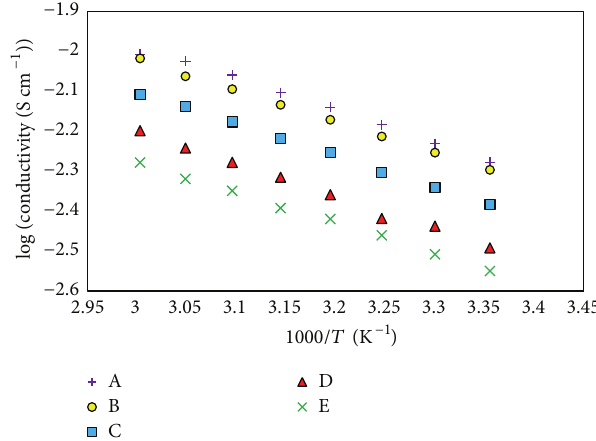
Figure 7: Temperature dependence of conductivity for phthaloyl- chitosan-based electrolyte containing different ratio of LiI: Pr 4 NI binary